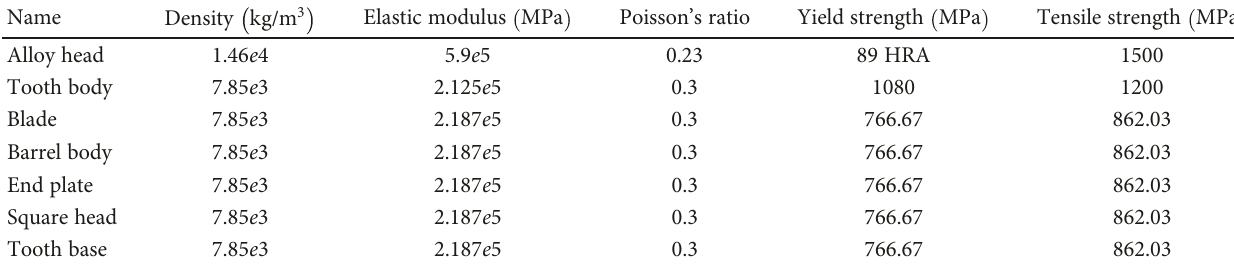
Figure 1: The three-dimensional model of the drum cutting coal rock and the pick Table 1: Spiral drum material parameters.